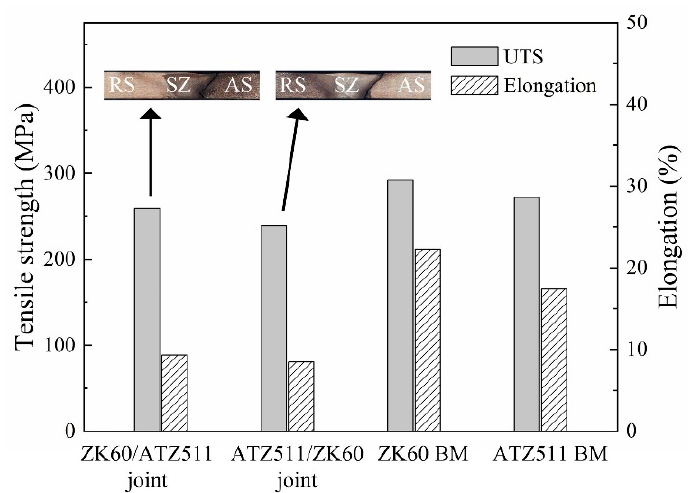
Figure 12. Transverse tensile properties of the welded joints and the BMs (UTS: ultimate tensile strength).